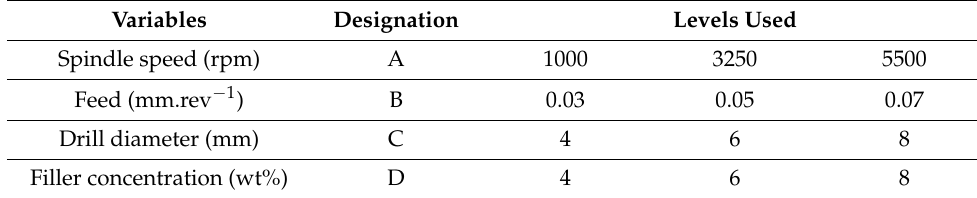
Table 2. Input factors with